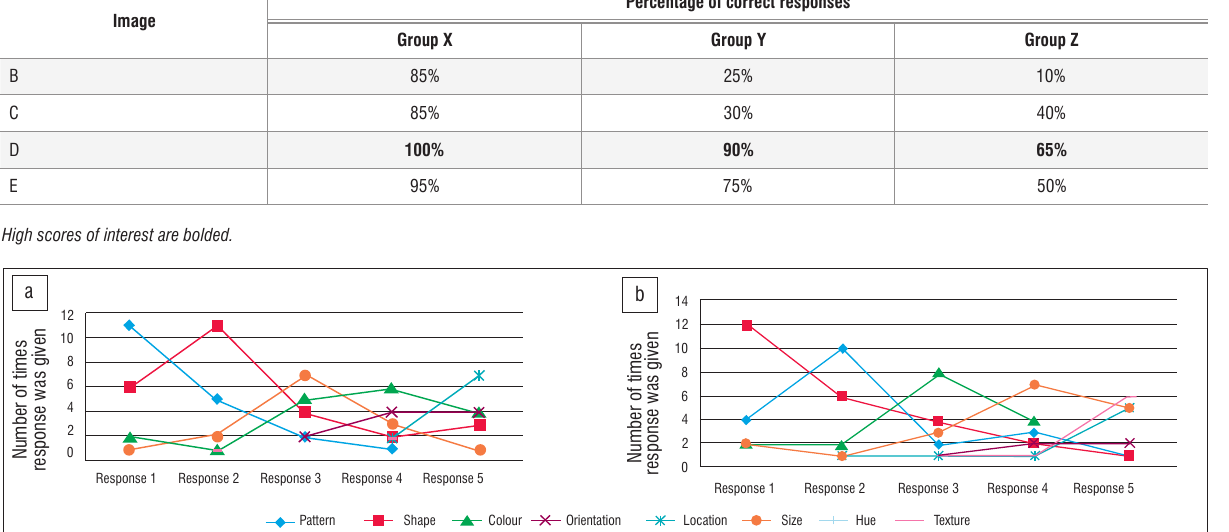
Table 1: Percentage of correct responses in each group in the feature identification task Image